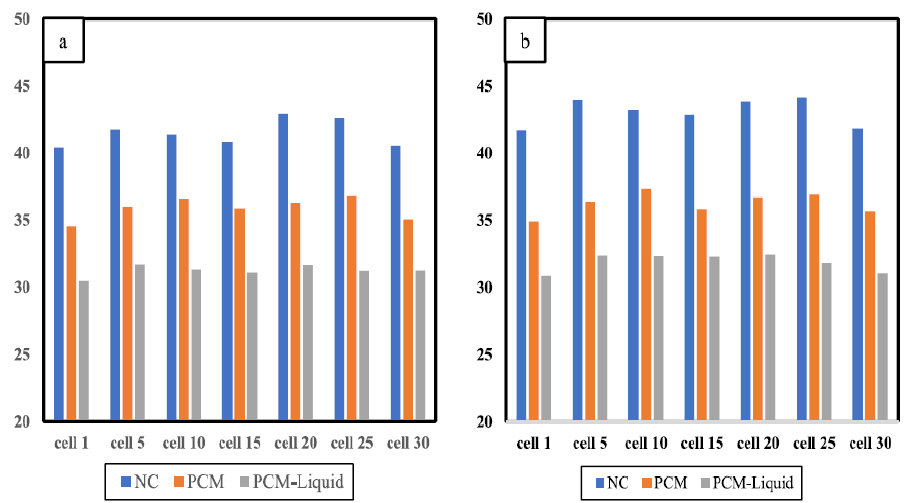
Figure 20. The temperature distribution for cells 1 to 30 under 4C rate during 700 s: ( a ) during charging; ( b ) during discharging [92].